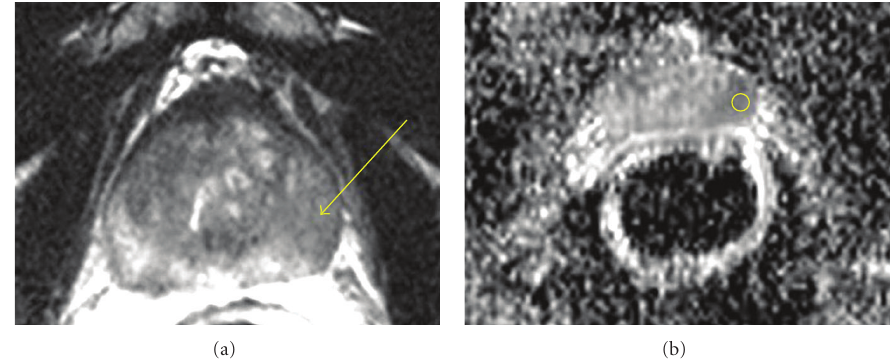
Figure 1: (a) T 2 -weighted MRI of 68yo prostate cancer patient with GS 3 + 4 and (b) corresponding ADC map with low signal on the left base PZ.